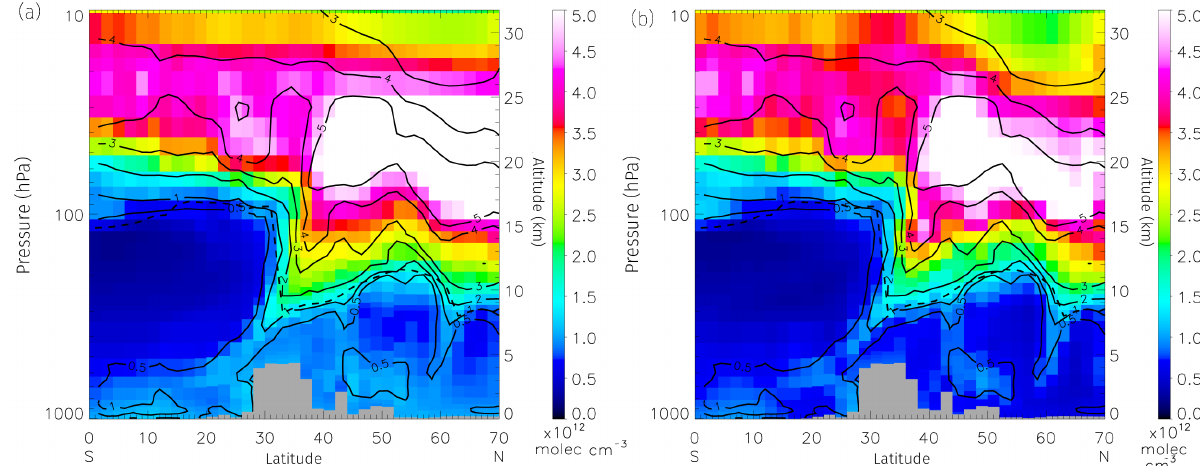
Figure 14. Two meridional cross sections over the Tibetan Plateau, located at 84 . 25 ◦ E on 25 February 2008, 06:00UTC. The colours indicate the ozone concentration from the free model run (a) and the assimilation of both GOME-2 and OMI (b) . The solid contours show the ozone concentrations from the ERA-Interim reanalysis. The dashed line shows the thermal